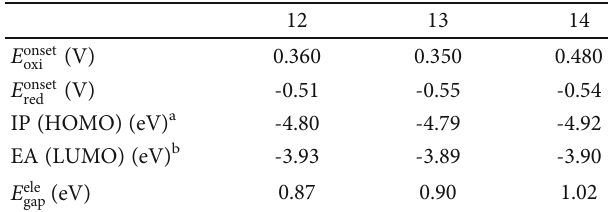
is the onset red is the electrochemical gap